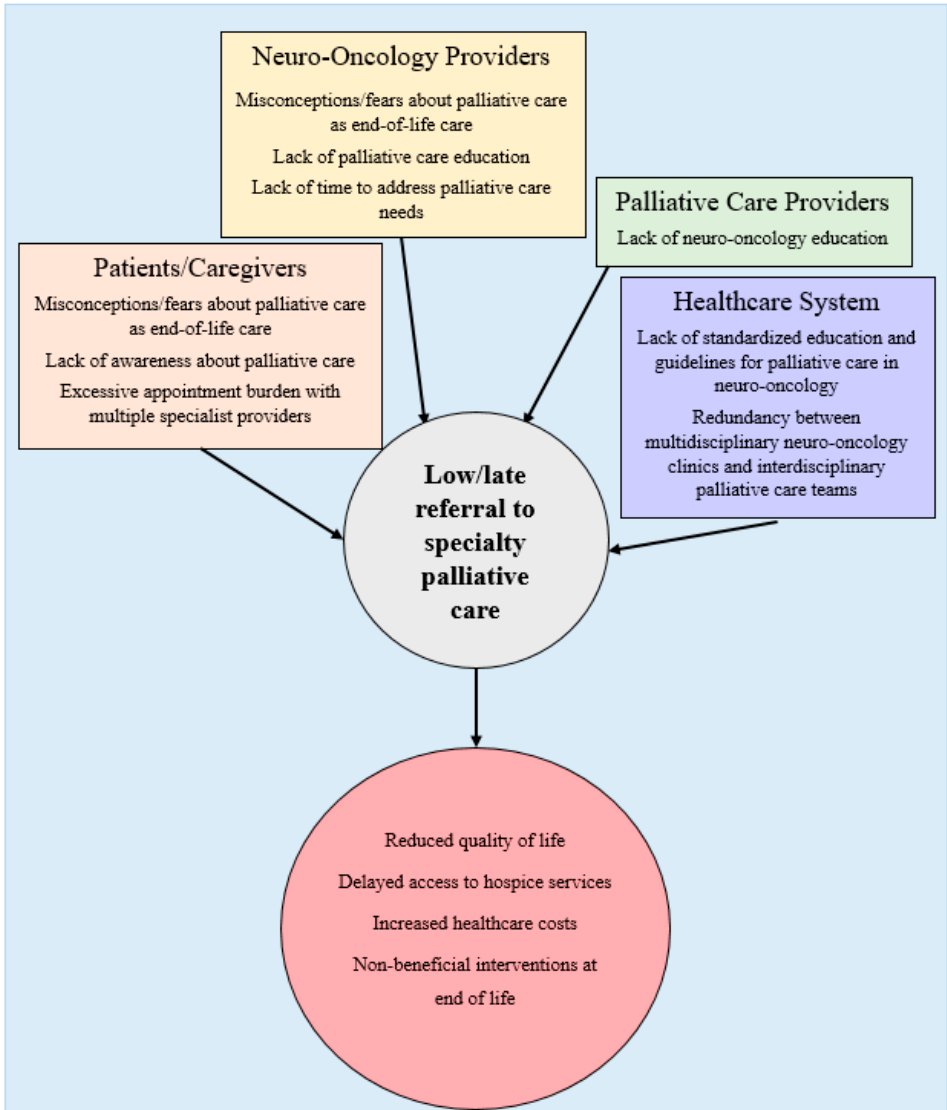
Figure 2. Our novel conceptual model of potential barriers to specialty palliative care referral among patients, providers, and the health care system, based on the literature [77].